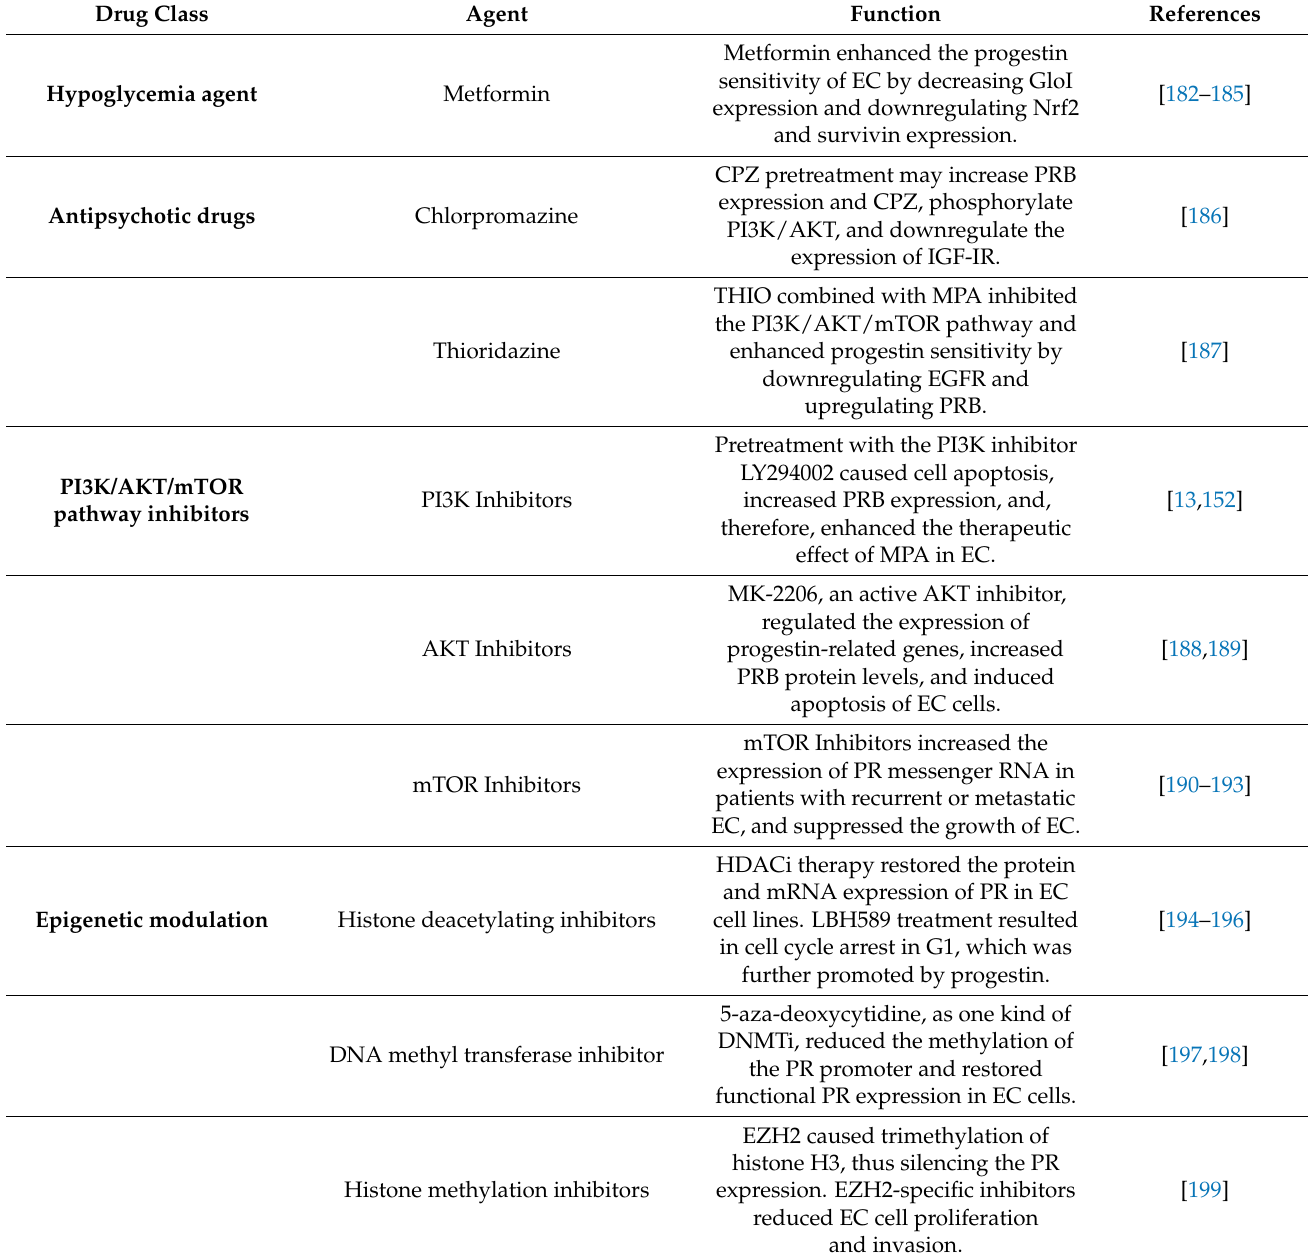
Table 3. Cocktail drug administration to reverse progestin